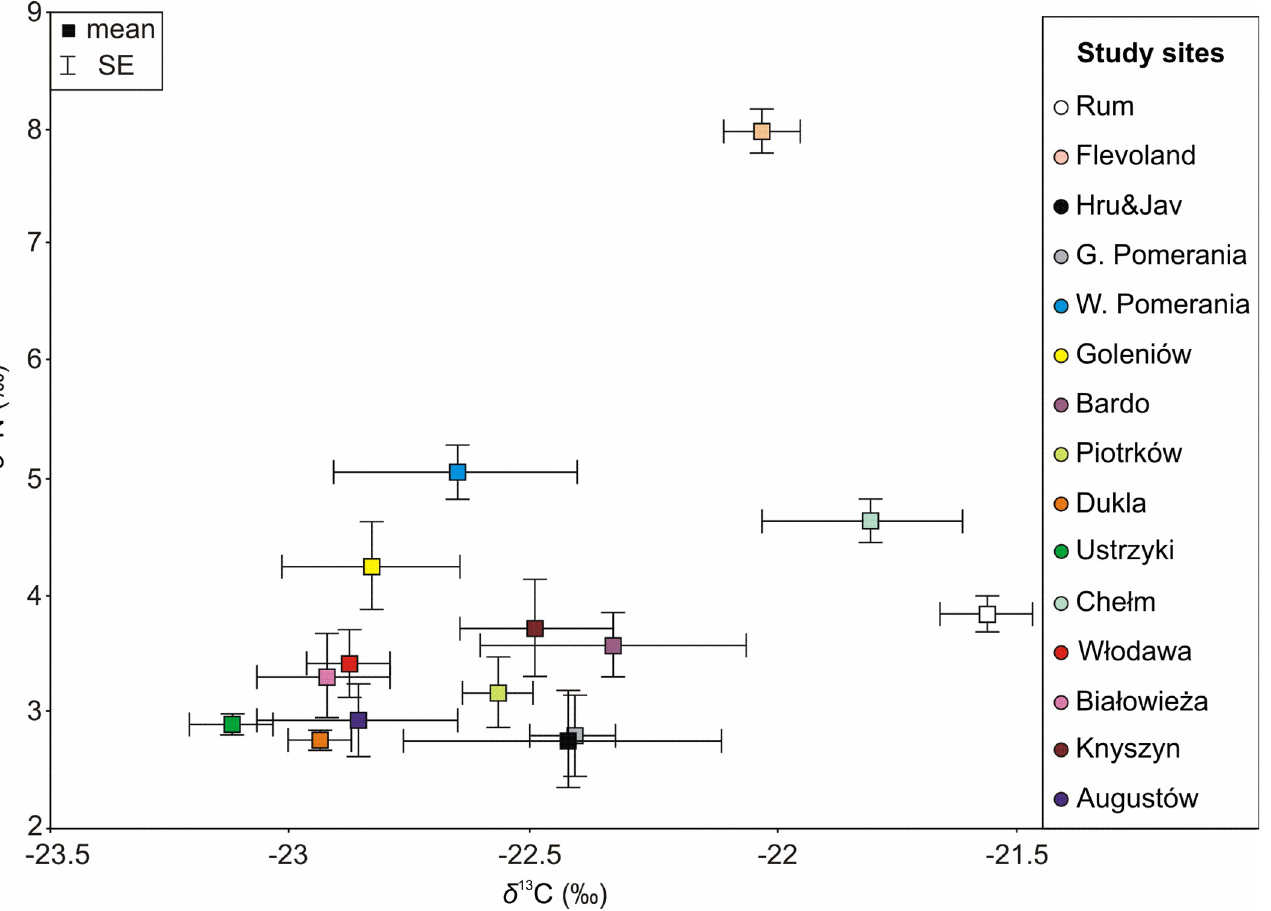
Fig 2. Mean values and standard errors of the mean (SE) of stable carbon and nitrogen stable isotope compositions ( δ 13 C and δ 15 N values) in bone collagen of red deer inhabiting different study sites.